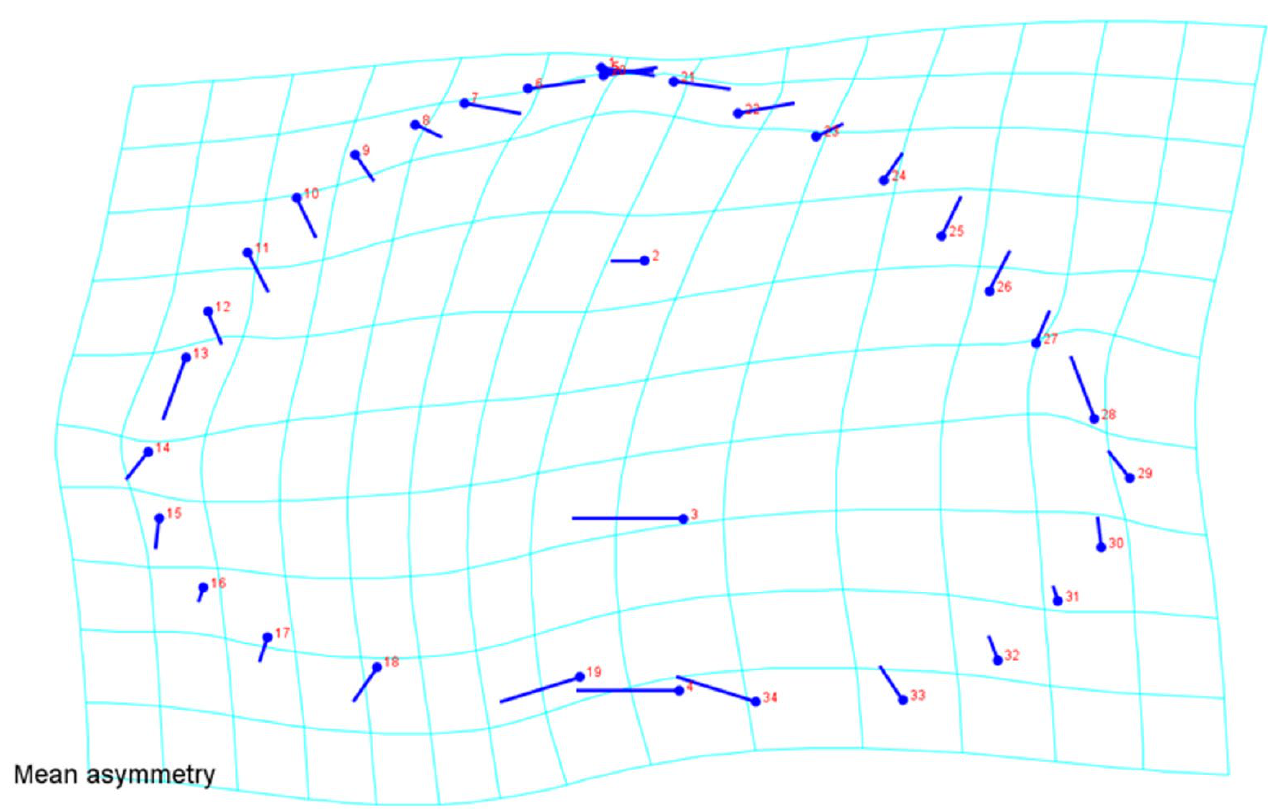
Figure 3. Deformation grid for the frontal view of Testudo . Directional asymmetry is shown as the difference between the averages of all original and reflected configurations. Transformation grids illustrate the shape changes from overall mean along Principal Component 1. Circles indicate the locations of the landmarks in the mean shape of the sample; sticks indicate the changes in the relative positions of the landmarks. It appears a clear shape patterns of lateral right displacement.